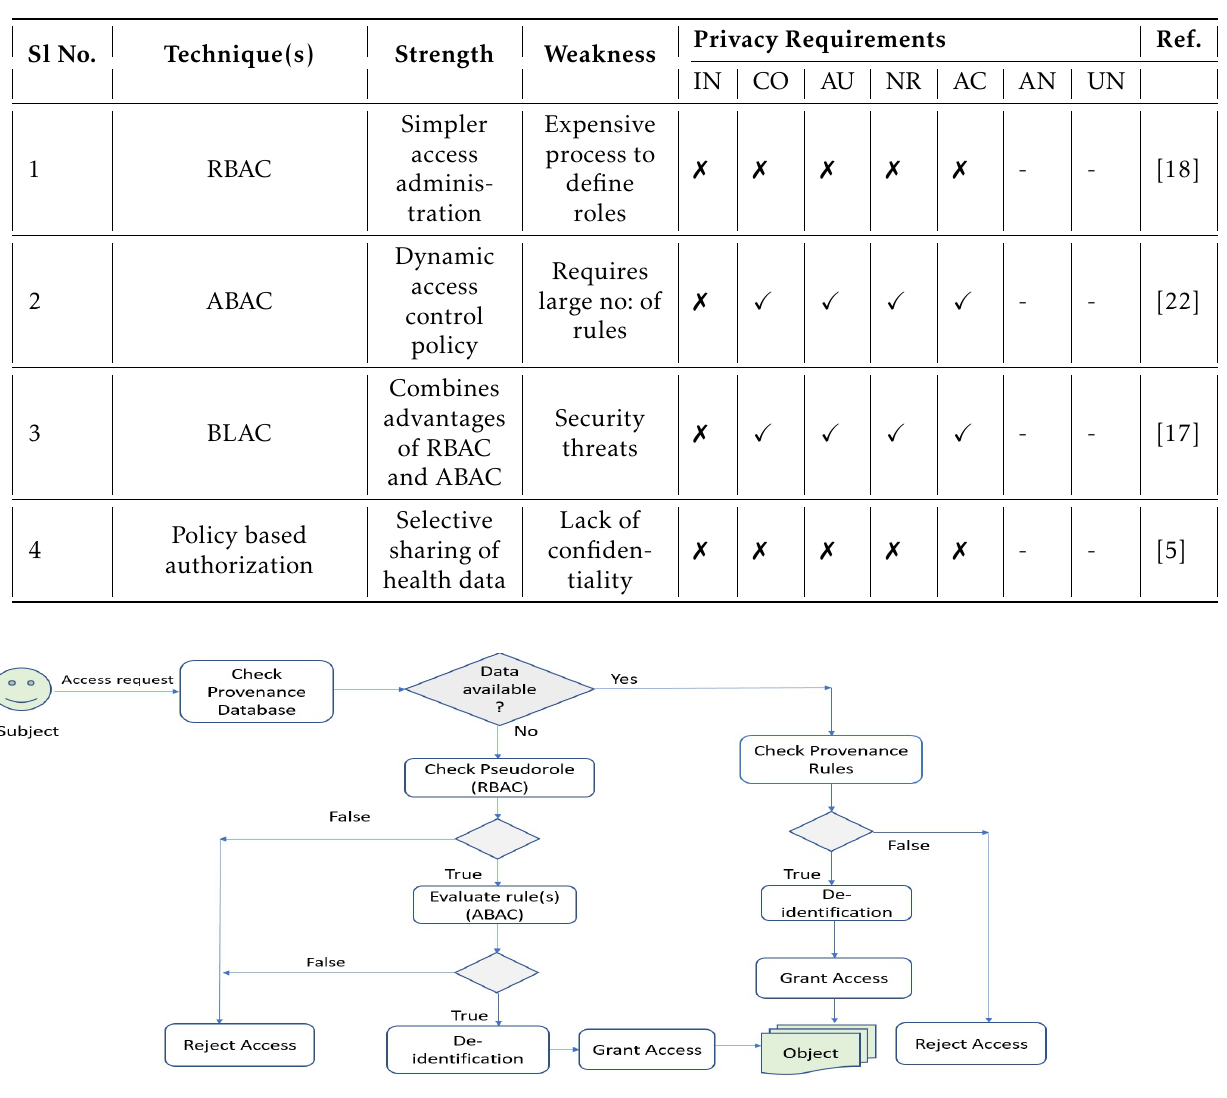
Figure 2. Overview of MLAC